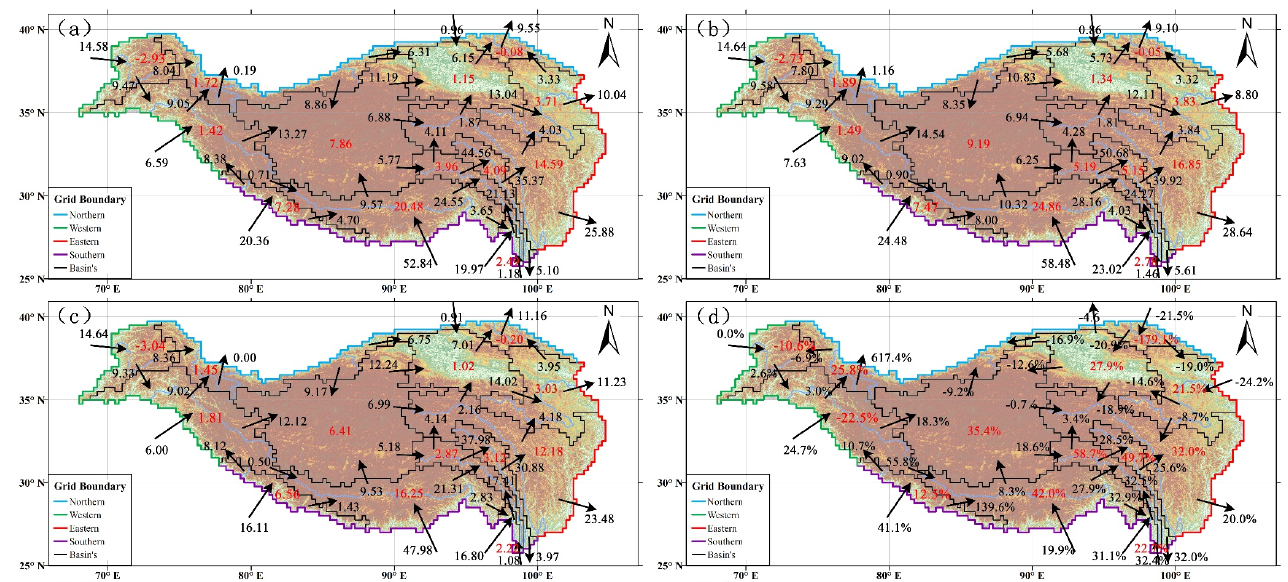
Figure 5. Distribution map of summer water vapor transport and budget on the TP, the arrow indicates the direction of water vapor flux, the black value is the net water vapor flux at the boundary of the basin, and the red value is the instantaneous WVB of the basin, unit: 10 6 kg s − 1 ; ( a ) climatic state, ( b ) strong year, ( c ) weak years, and ( d ) proportion of the difference between strong and weak years.